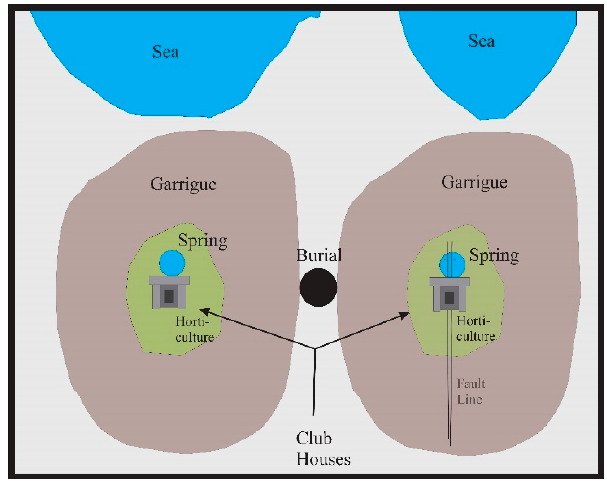
Figure 3. Club house models of landscape, showing the relationship to different parts of the land and seascape: sea, garrigue, burial places, horticulture and springs.